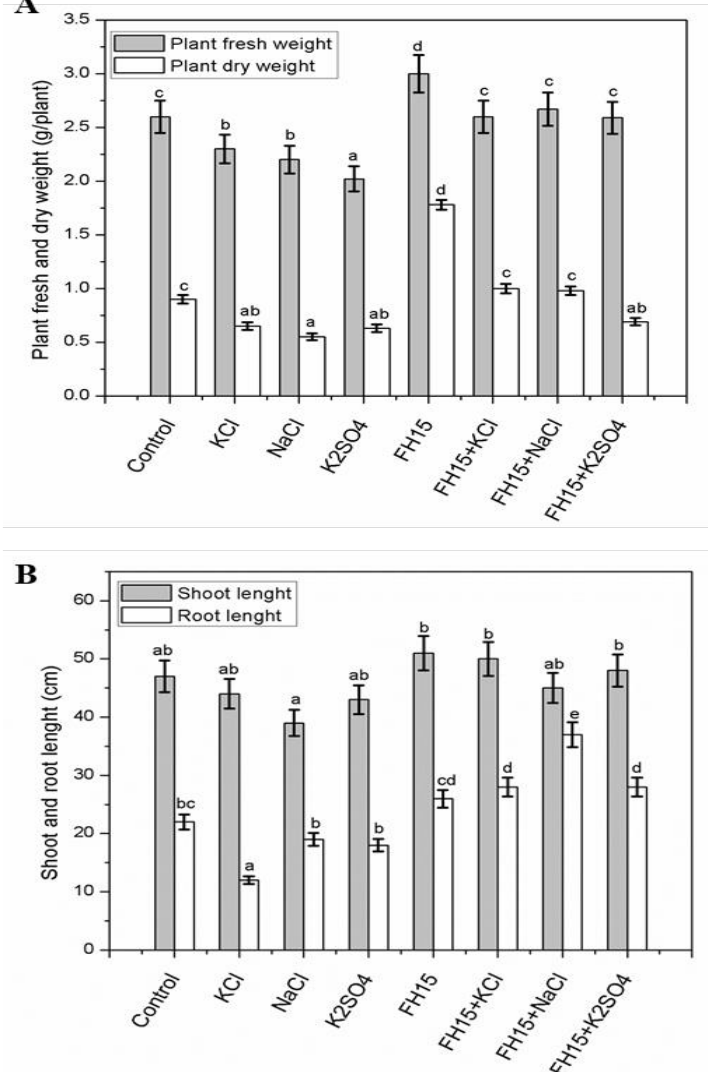
Figure 2. Impact of various salts on maize ( A ) fresh and dry biomass and ( B ) shoot and root length with or without endophytic fungal strain C. membranifaciens FH15 inoculation. The bars represent mean with ± SE and the different letters on the bars represent significance at p = 0.05.